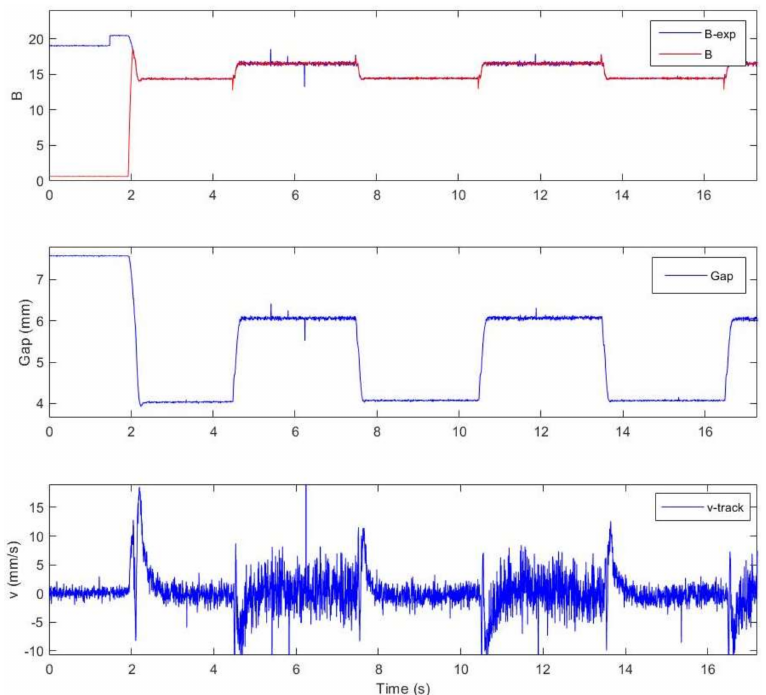
Figure 16. The magnetic flux, suspension gap, and vertical track velocity under the elastic track condition.